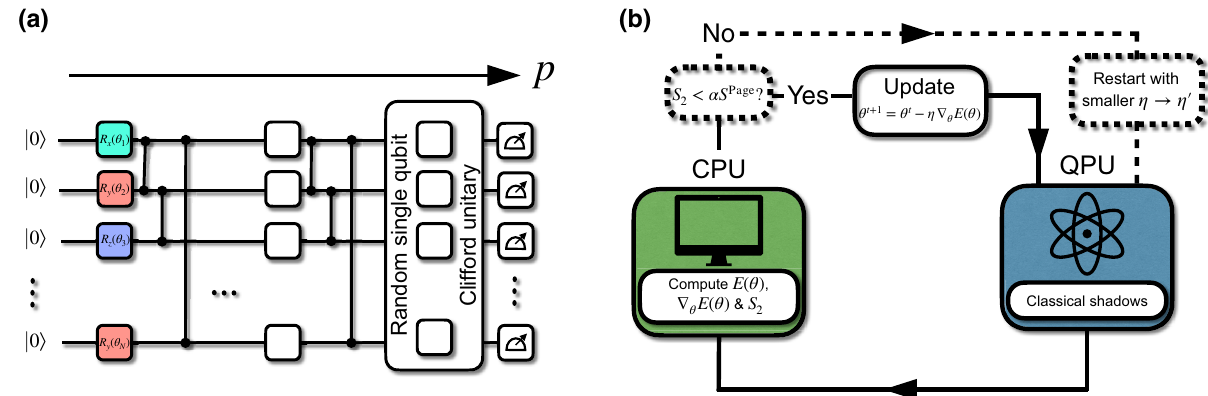
FIG. 1. (a) Illustration of the variational quantum circuit U ( θ ) | 0 (cid:2) that is considered in the main text followed by the shadow tomog- raphy scheme [25]. The variational circuit consists of alternating layers of single-qubit rotations represented as boxes and entangling CZ gates shown by lines. The measurements at the end are used to estimate values of the cost function, its gradients, and other quantities. (b) The original hybrid variational quantum algorithm shown by solid boxes can be modified without incurring significant overhead as is shown by the dashed lines and boxes. The modified algorithm tracks entanglement of small subregions and restarts the algorithm if it exceeds the fraction of the Page value that is set by parameter α . The full algorithm is efficient; rigorous sample complexity bounds are provided in Appendix